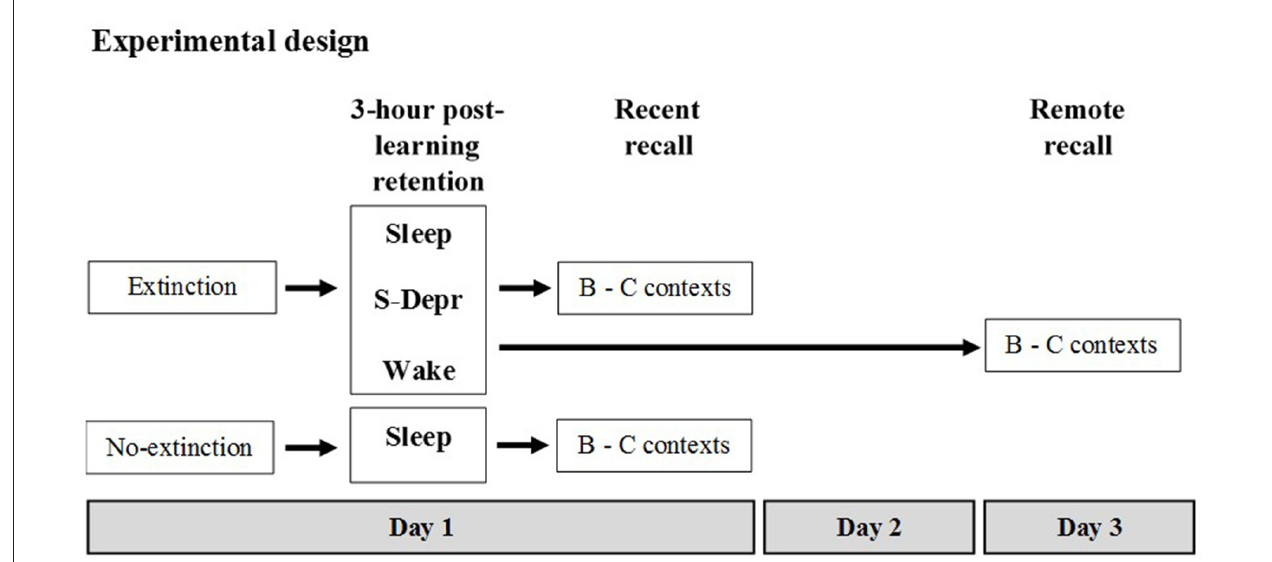
FIGURE 1 | Experimental design (see text for details). After familiarization to the different contexts used in the experiment and after having acquired the operant behavior (rewarded lever press) on the day before, five groups of rats were subjected to Extinction training in Context B (Day 1). A 6th No-extinction control group remained awake in their home cages during this period. Extinction training was followed by a 3-h retention period during which rats of the Sleep groups slept, rats of the S-Depr groups were deprived from sleep, and the rats of the Wake group remained spontaneously awake. The post-learning retention period for the Sleep, S-Depr and No-extinction control groups took place between 10:00 a.m. and 1:00 p.m. of the light phase. For the Wake group the retention period took place between 10:00 p.m. and 01:00 a.m. of the dark cycle. Recall was tested in the extinction Context B and in a different Context C either right after the 3-h retention period (in the Sleep/Recent, the S-Depr/Recent, the Wake/Recent and the No-extinction control groups) or 48 h after Extinction training (Day 3, Sleep/Remote, S-Depr/Remote groups). Data from the S-Depr/Recent and Wake/Recent groups were pooled for analyses because these groups showed closely comparable performance at the recall